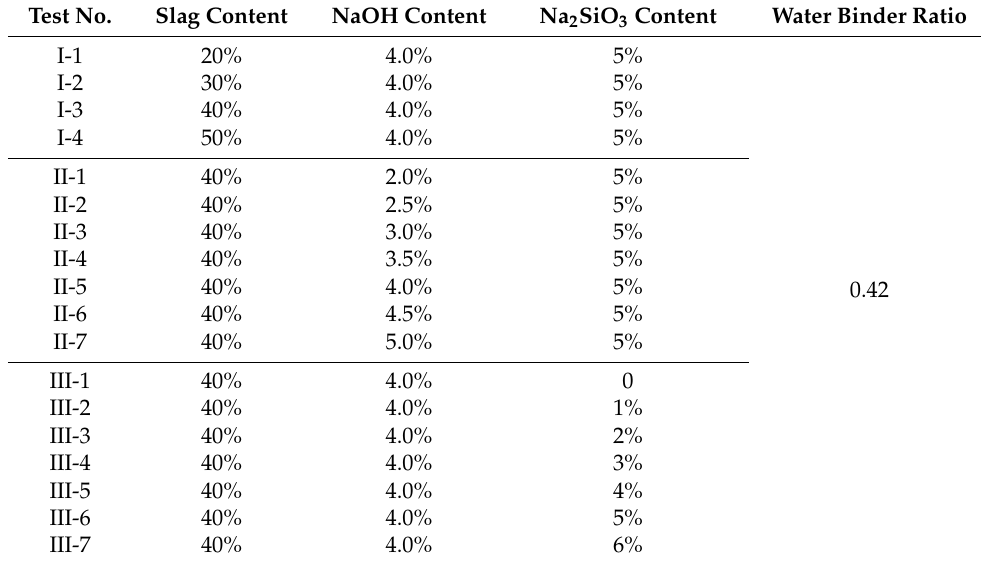
Table 5. Experimental scheme